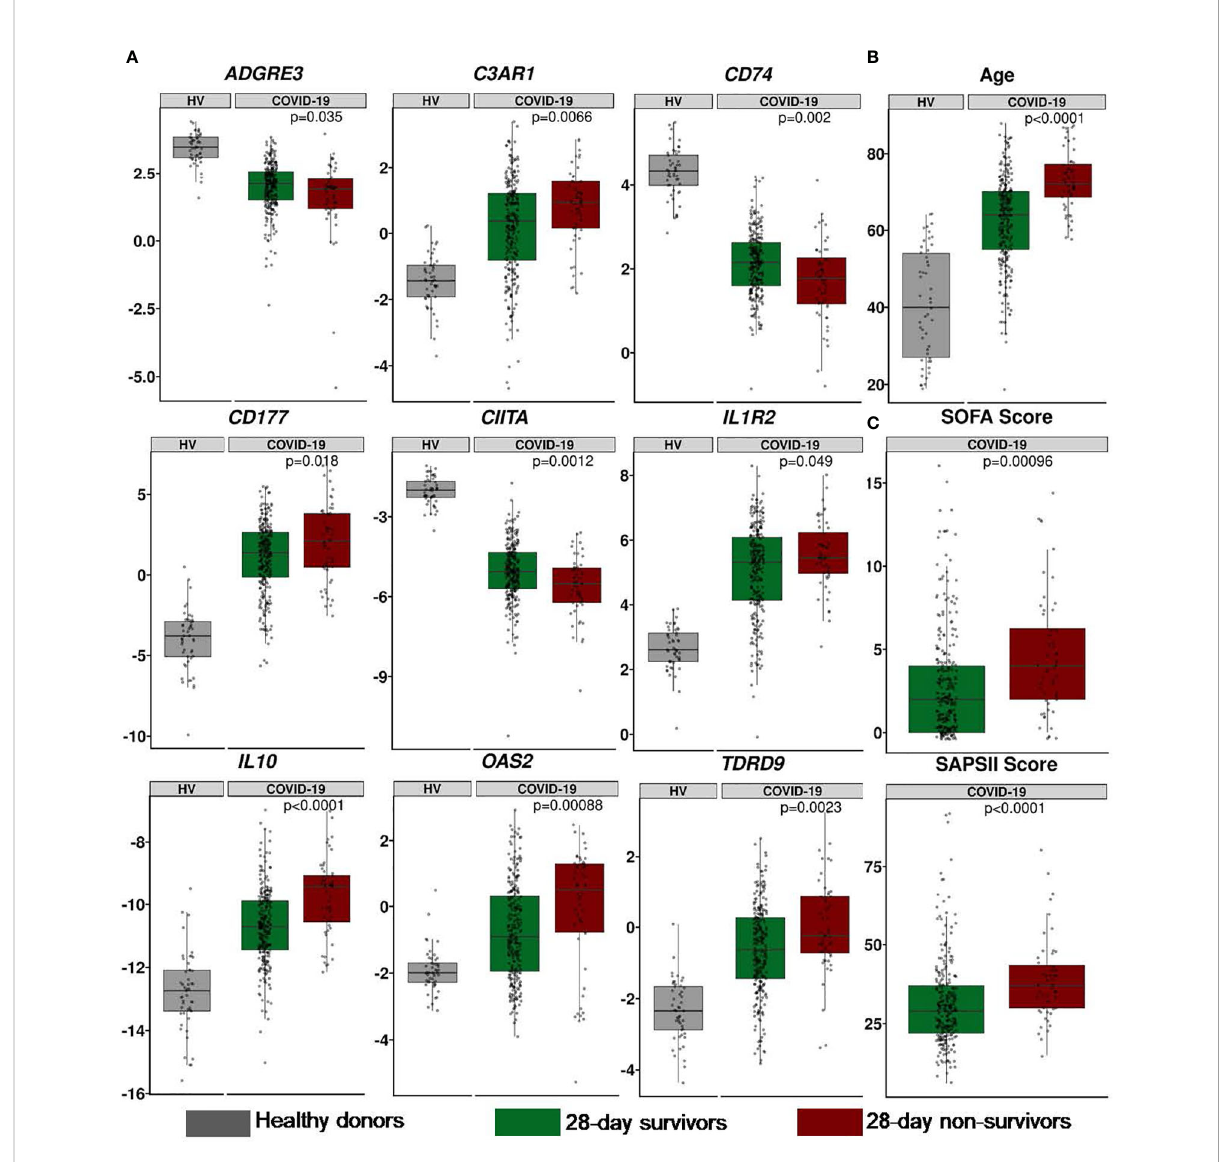
FIGURE 2 Description of IPP 9-mRNA and clinical parameters in the RICO cohort of 309 critically ill COVID-19 patients. (A) Expression of IPP markers (values are presented as normalized Cp). (B) Age (years). (C) Clinical scores. All parameters are presented at admission between 28-day survivors (green) and non-survivors (red). When relevant, reference values of healthy donors are presented in grey. The p-value were generated using a Mann-Whitney-Wilcoxon test between survivors and